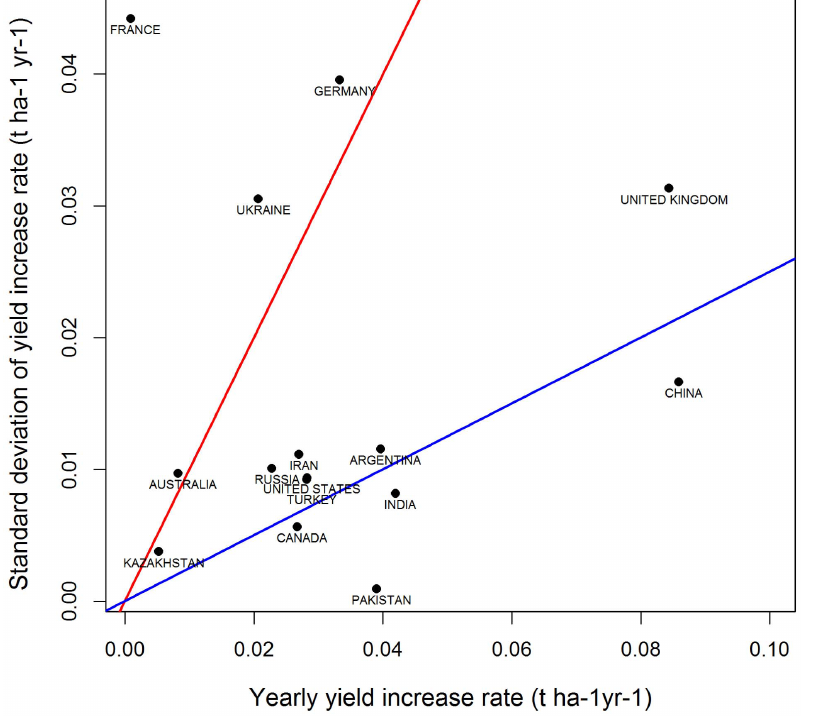
Figure 7. Standard deviation of yield increase rate (t ha 2 1 yr 2 1 ) versus estimated yield increase rate (t ha 2 1 yr 2 1 ) obtained with DLMs for the top 15 largest wheat producing countries. Countries above the red line and countries below the blue line show a coefficient of variation (100*standard deviation/estimated value) higher than 100% and lower than 25% respectively.